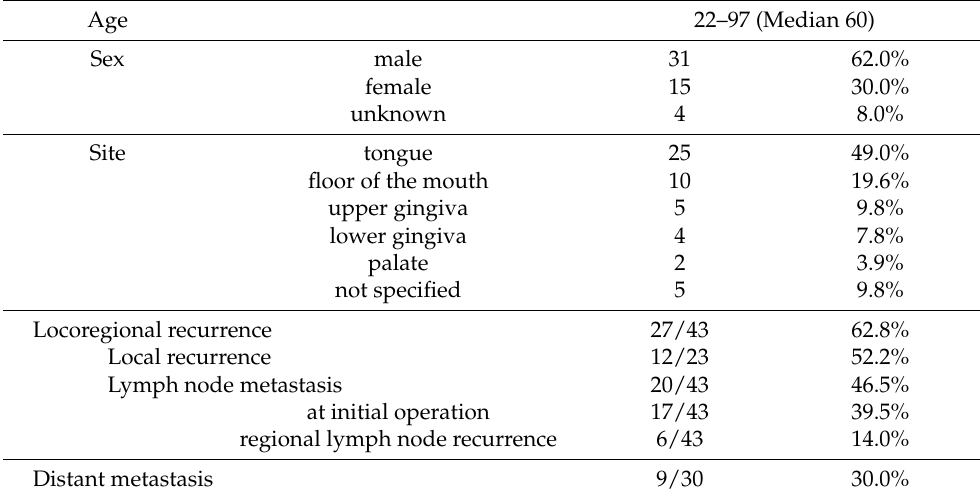
Table 2. Summary of the literature